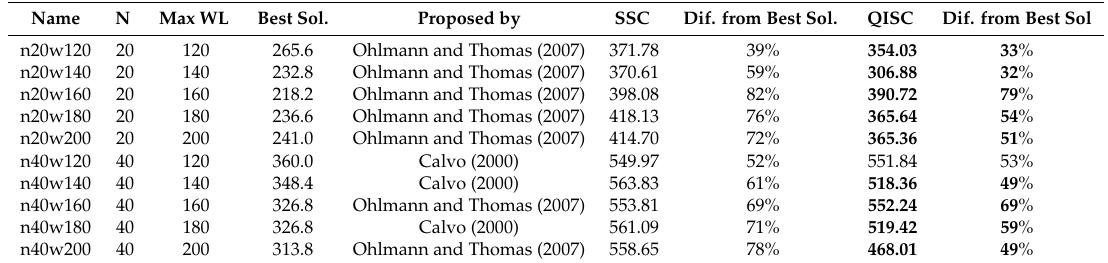
Table 2. Computational Results- SSC vs. QISC comparative study.